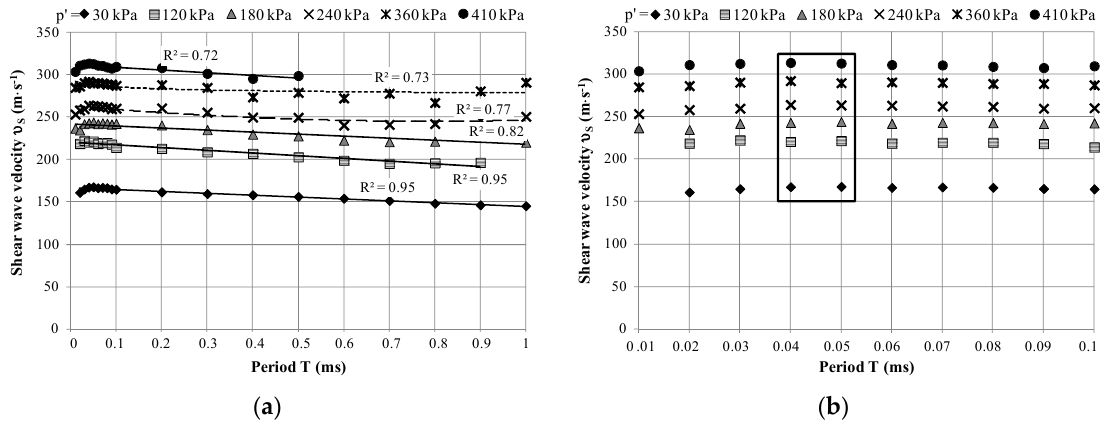
Figure 8. Variation of measured υ S with period: peak-to-peak method. ( a ) Period’s range from 0 to 1 ms; ( b ) Period’s range from 0.01 to 0.1 ms.